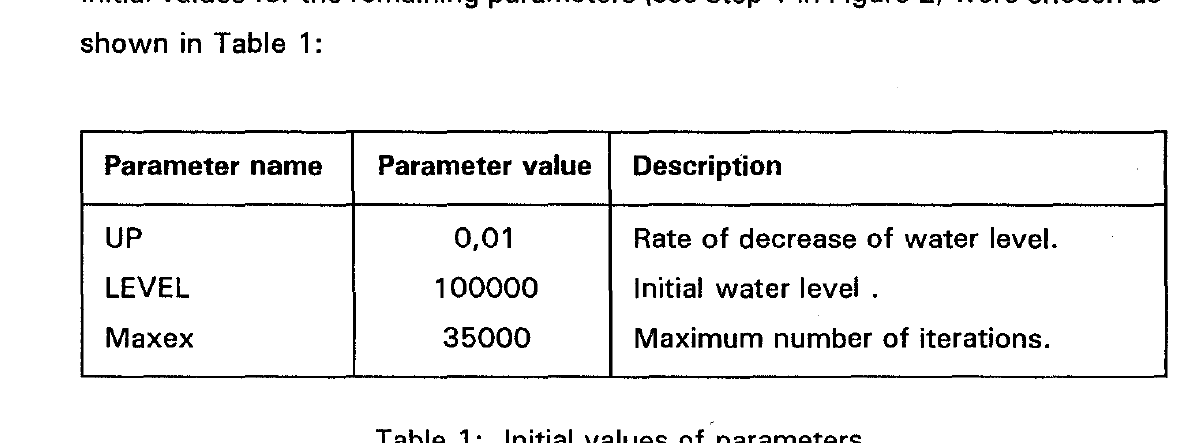
Table 1: Initial values of